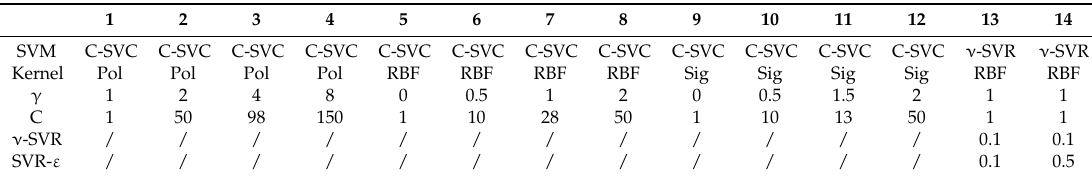
Table 2. The classification